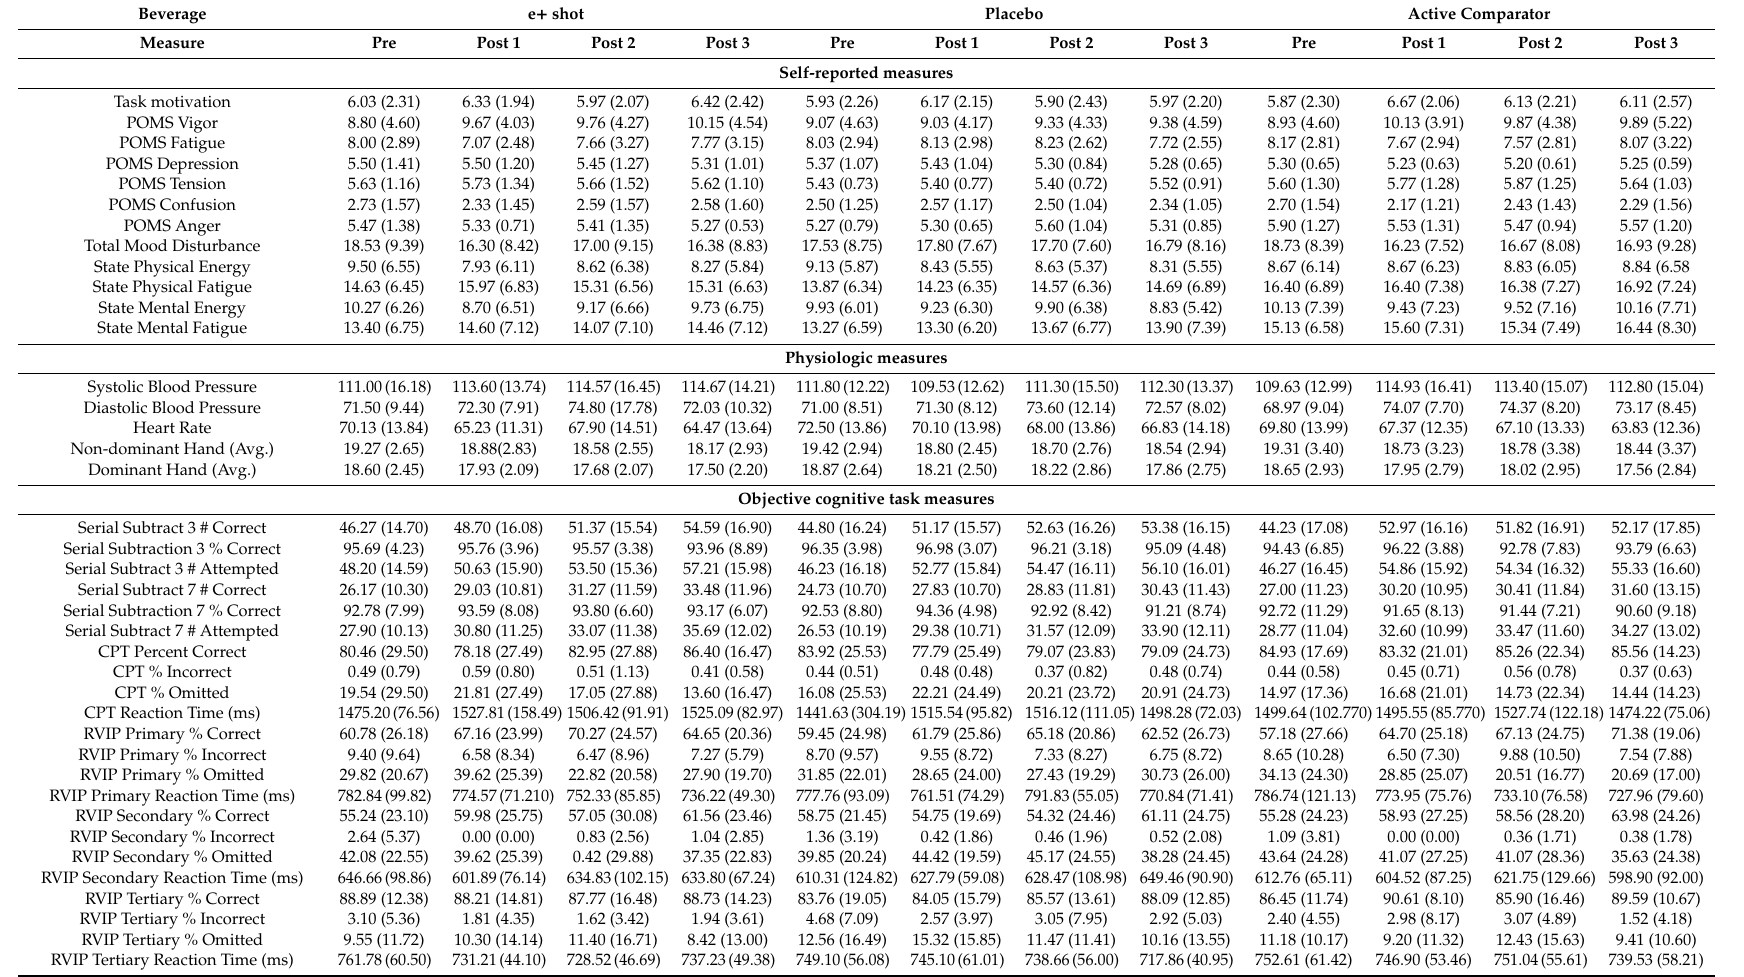
Table 4. Mean (SD) for all